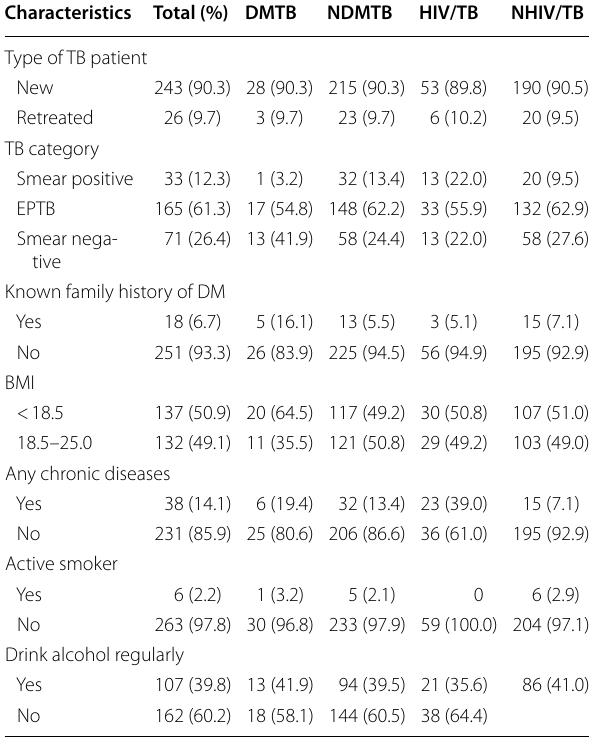
Table 2 Clinical characteristics and life style of TB patients Characteristics Total (%) DMTB